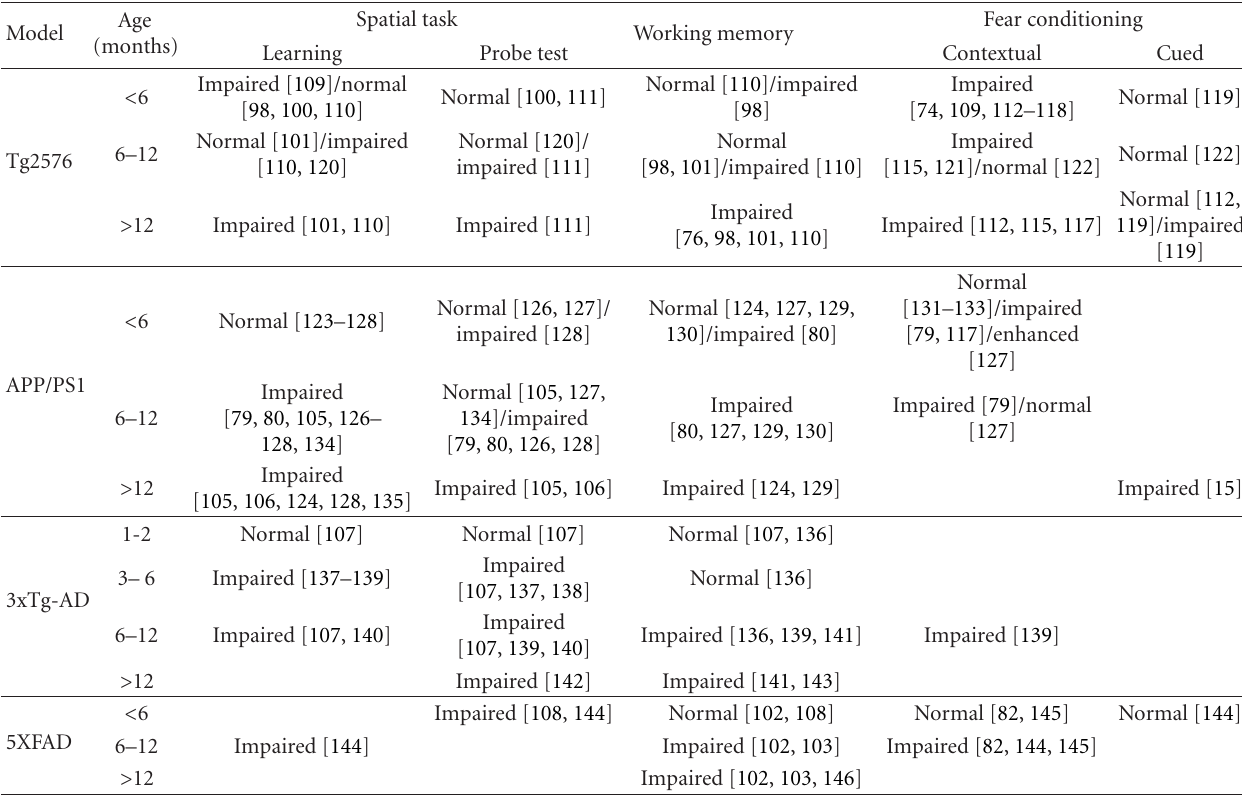
Table 2: Progressive cognitive impairments in APP AD transgenic